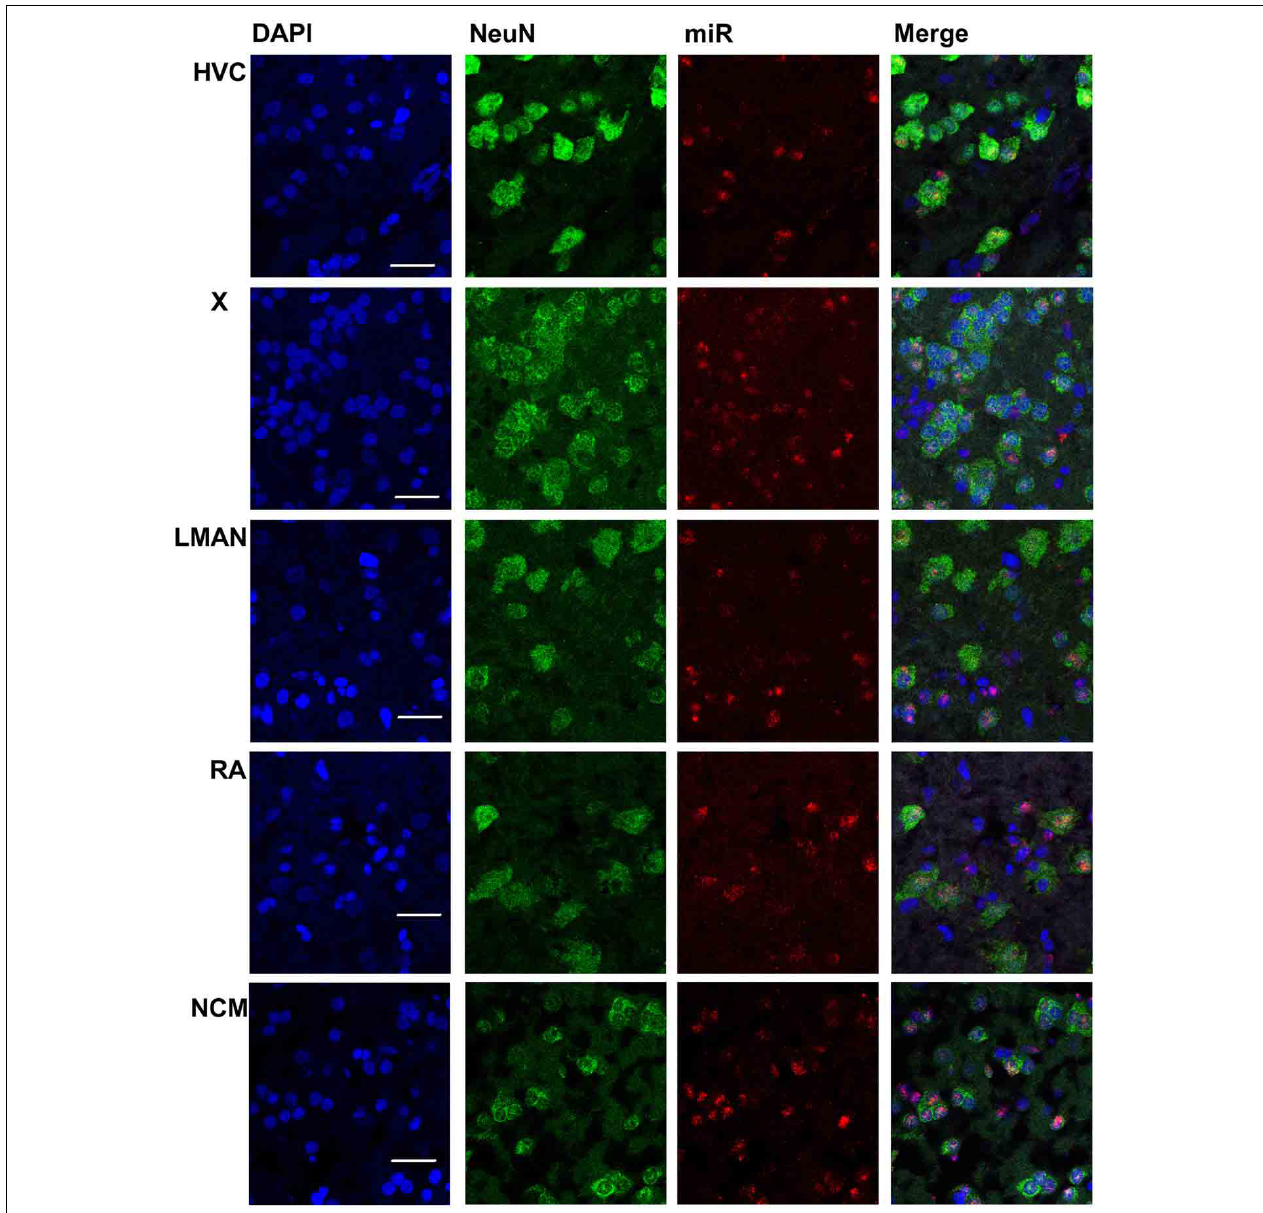
FIGURE 3 | Mapping of miR-2954 expression in zebra finch song nuclei (zoom in). High-magnification images in the song nuclei show the overlapping of miR-2954, DAPI (labeling all nuclei), and NeuN (labeling neurons). Scale bar represents